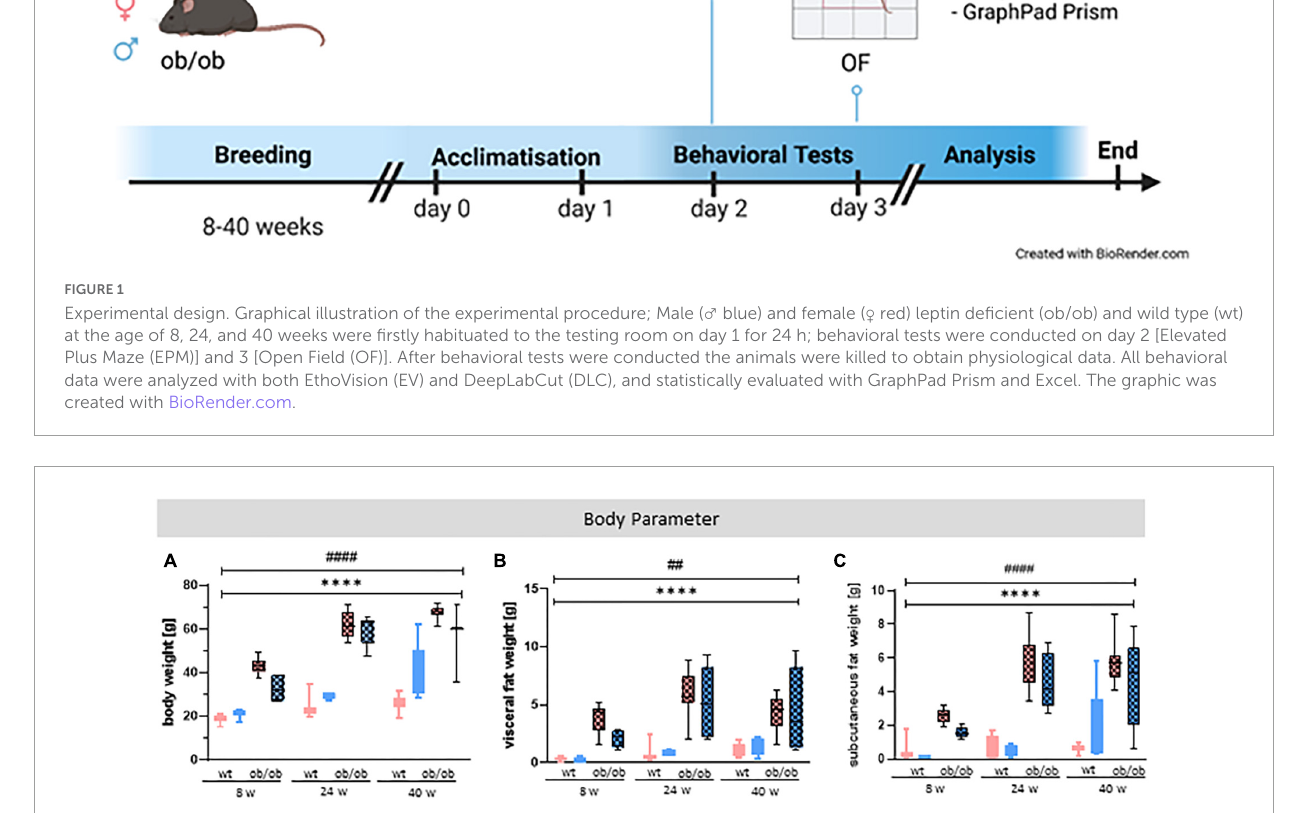
FIGURE2 Statistical investigation of different body parameters to characterize obesity. (A) Body weight (g), (B) visceral, and (C) subcutaneous fat weight (g) of female (red) and male (blue) mice at age of 8, 24, and 40 weeks were analyzed at the end of the experiment. The group size was as follows: n (wt) = 45 (A) , 41 (B) , 33 (C) , n (ob/ob) = 42 (A,C) , 45 (B) . Significances of differences between the groups were tested by three-way ANOVA. The analysis revealed a genotype and age, but no sex effect for all three examined parameters. Statistical significance was set at ∗∗∗∗ p < 0.0001 for genotype effect and ## p < 0.01 or #### p < 0.0001 for age effect. ob/ob, leptin deficient mice; wt, wild type; w, weeks (these abbreviations will be consistently used in all following plots, unless stated